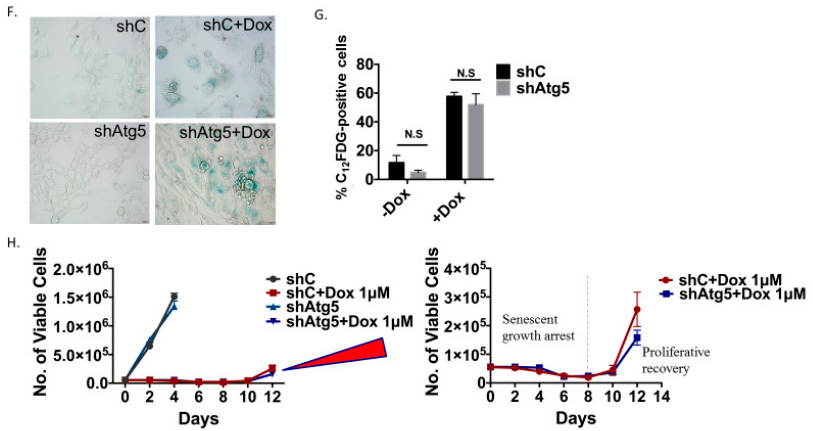
Figure 4. Inhibition of autophagy does not interfere with the induction or the recovery from senescence in 4T1 cells exposed to doxorubicin ( A ) Temporal response to Dox (1 µM) in 4T1 cells after pharmacological inhibition of autophagy with CQ. Viable cell number was determined at the indicated time points after treatment with Dox in combination with CQ (10 µM). Adjoining figure shows expanded scale for lower portion of the graph. ( B ) Knockdown of Atg5 in 4T1 cells confirmed by Western blot. ( C ) Western blot of Atg5 deficient 4T1 exposed to Dox showing conversion of LC3BI to LC3BII in WT cells, accumulation of LC3BI with decreased LC3BII in autophagy deficient cells. ( D ) Assessment of apoptosis by FACS analysis 24 hours post-treatment with Dox using APC/7AAD [Annexin 5/propidium iodide (PI) equivalent] dye. Genetic inhibition of autophagy did not result in increased apoptosis. ( E ) Colony formation assay comparing clonogenic survival of shControl and shAtg5 4T1 cells in response to multiple Dox concentrations. ( F ) Induction of senescence determined by SA- β -gal staining in shControl and shAtg5 4T1 cells treated with 1 µM Dox (20x objective). ( G ) Percent senescence based on quantification of C 12 FDG staining 48 hours after exposure of shControl cells and shAtg5 cells to Dox. ( H ) Temporal assessment of growth arrest followed by proliferative recovery in shControl and shAtg5 4T1 cells. Viable cell number was determined at the indicated time points after treatment with doxorubicin. Adjoining figure shows expanded scale for lower portion of the graph. (n.s. = no significant difference)